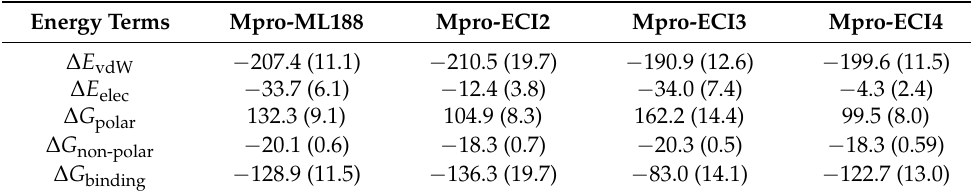
Table 2. Average values and corresponding standard deviations (in parentheses) of the MM-PBSA binding free energy (BFE) and energy components (kJ/mol) calculated from the respective structural ensembles of the four Mpro-inhibitor